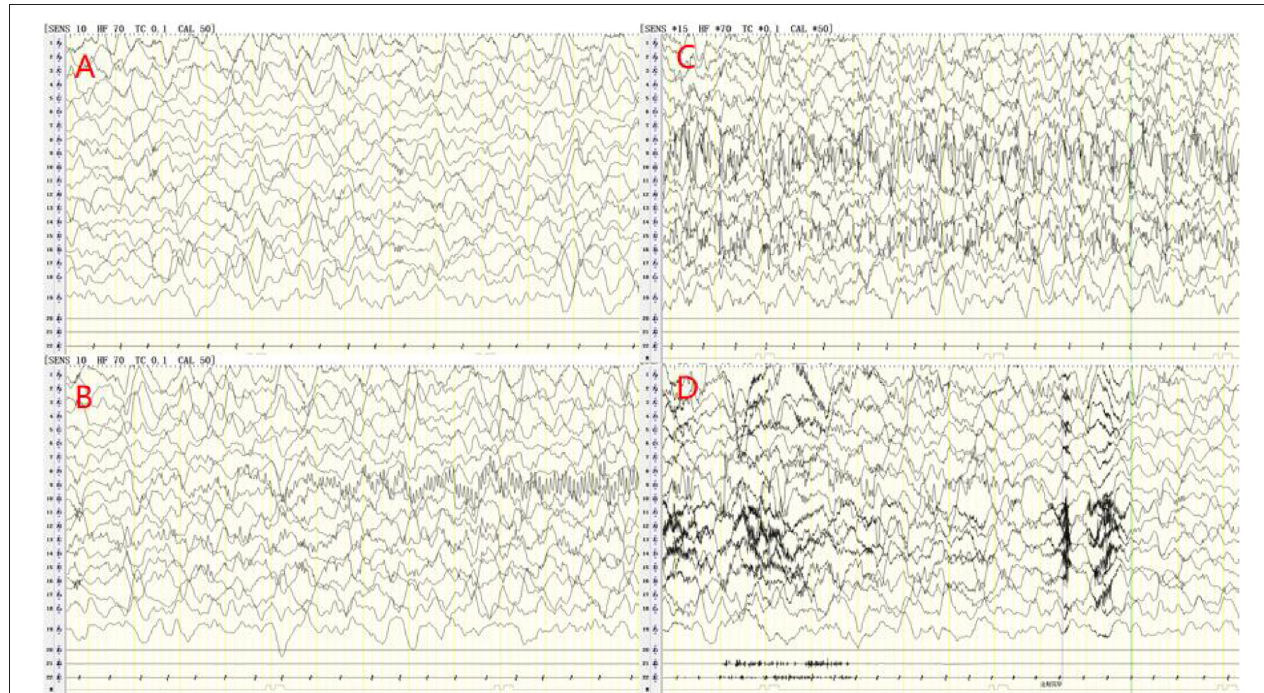
FIGURE 4 | Electroencephalogram (EEG) of a 6-years old male patient with anti-NMDA receptor encephalitis. The delta rhythm (1.2–3Hz, 80–250 UV) was used as the main background, with a small amount of θ rhythms (4–5Hz, 40–100 UV) and slightly more low amplitude beta activity (A) . During video-EEG monitoring, the child had a seizure with oblique eyes, unconsciousness and smack mouth. The synchronous EEG was the mid-amplitude spike rhythm starting from the left occipital and posterior temporal regions, and the discharge stopped briefly after intravenous injection of midazolam (B–D)